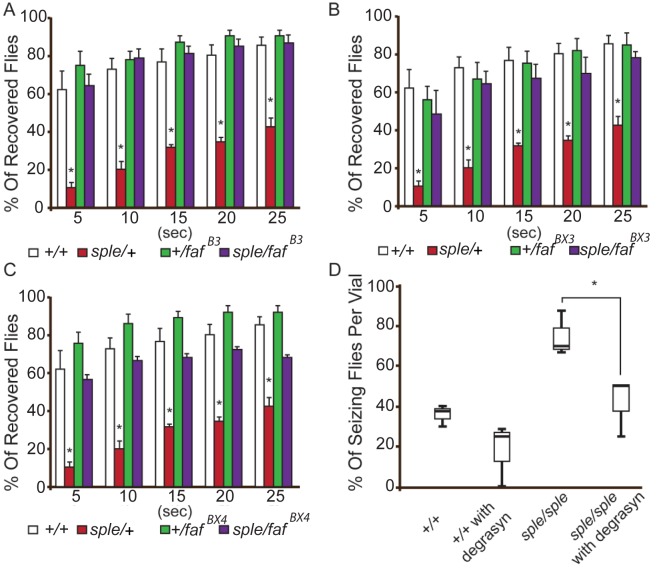
Genetic and pharmacological suppression of the seizure phenotype in prickle mutant flies.(A–C) Reducing faf dosage with three separate loss-of-function alleles ((fafB3, fafBX3, fafBX4; graphs A, B and C, respectively) suppresses the pksple-mediated seizure phenotype detected by the modified bang sensitivity assay. Six vials per genotype were assayed. D. Inhibition of faf activity with Degrasyn suppresses pksple-mediated seizure activity detected using the “fly flip” assay. Three vials per genotype were assayed. Note: +/+ = Oregon-R control flies; sple = pksple; sple/faf = pksple/+; +/faf. * = p < 0.05. Error bars = standard error. Each vial contains 5 males and 5 females.